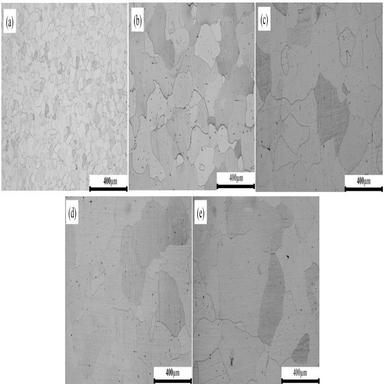
Metallography of industrial pure iron with different grain sizes at 930 ◦C: (a) untreated industrial pure iron, (b) annealed for 30 min, (c) annealed for 60 min, (d) annealed for 90 min, (e) annealed for 120 min.